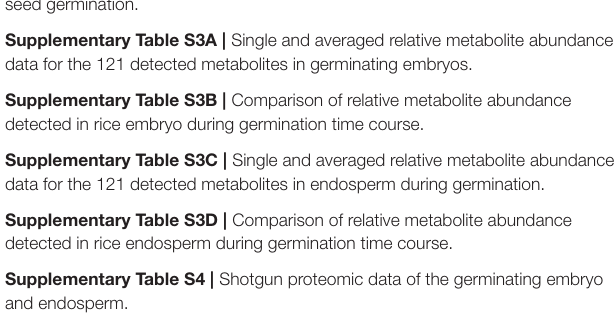
Supplementary Table 5 | Transcript correspondence with differentially accumulated proteins in the embryo and endosperm during rice germination. Supplementary Table S5A | The 265 significantly up-accumulated proteins in germinated rice embryos. Selection criteria: p < 0.05, log 2 ratio_E24vsE0 >